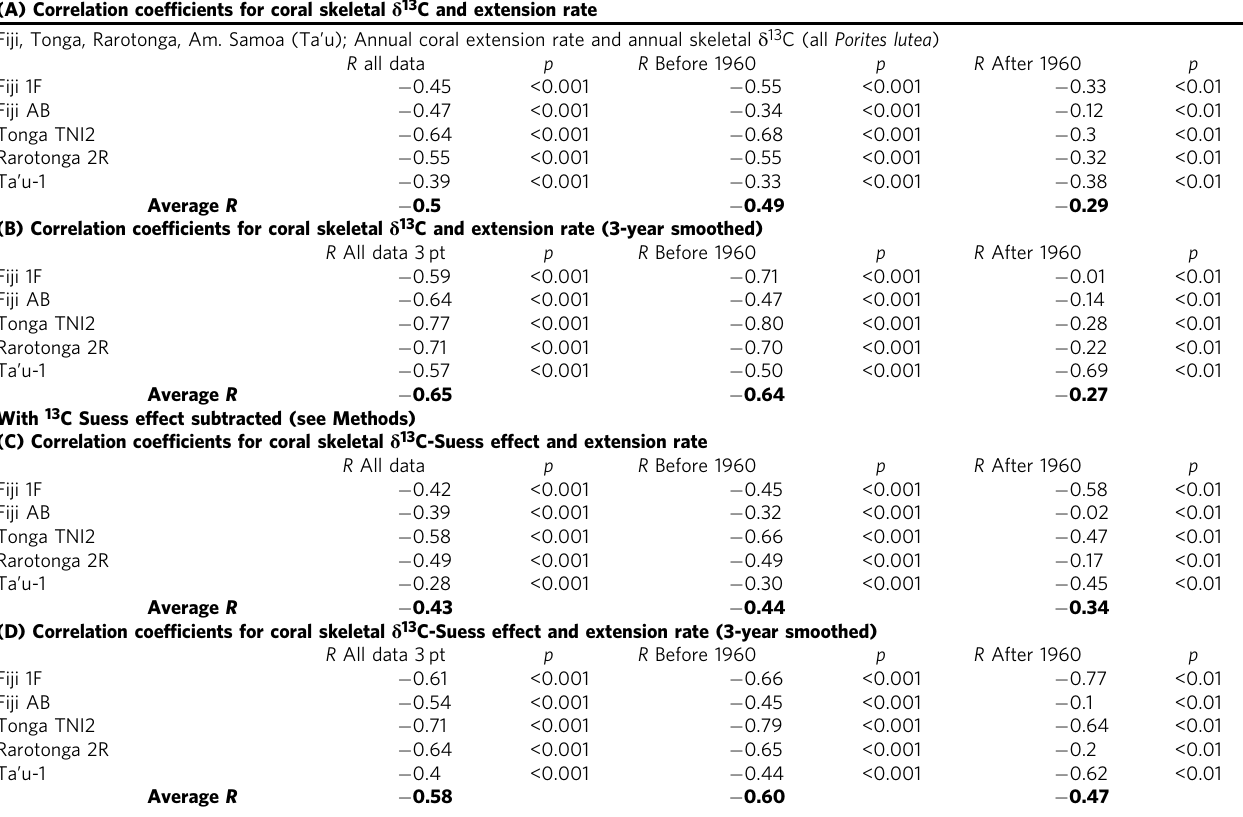
Table 1 Pearson correlation coef fi cients for Fiji, Tonga, Rarotonga, American Samoa (Ta ’ u); coral skeletal annual δ 13 C and annual extension rate (in